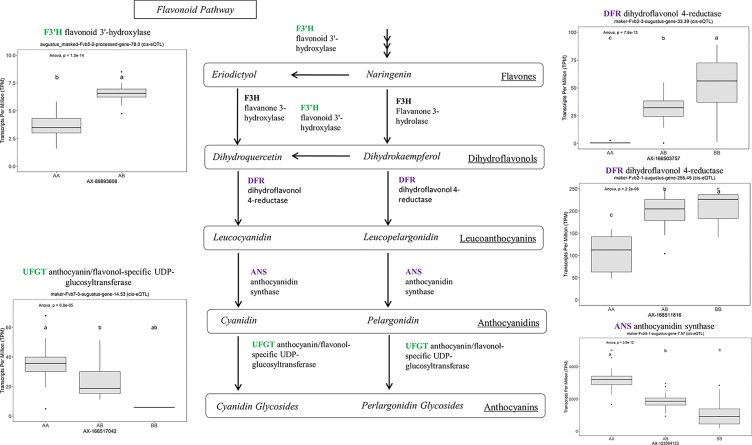
eQTL controlling transcript accumulation of key genes in the flavonoid pathway. Marker effect sizes are indicated by boxplots stratified by allelic state (AA, AB, or BB) and shown with ANOVA p-values. eQTL genes based on the ‘Camarosa’ genome are indicated as either possessing the highest sequence identity to the published sequence (purple) or not (green). Letters represent statistically separable means via Tukey’s HSD post hoc test (p < 0.05).